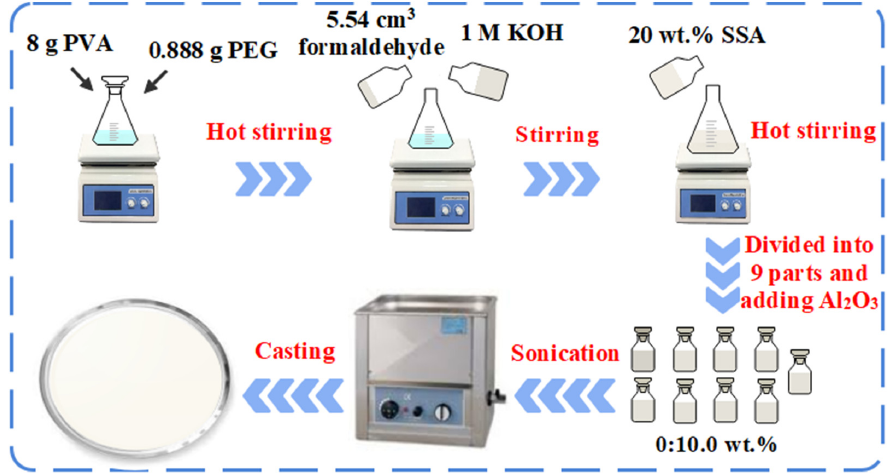
Figure 1. Preparation of PVA/PEG/Al 2 O 3 and PVA/PEG/SSA/Al 2 O 3 samples.